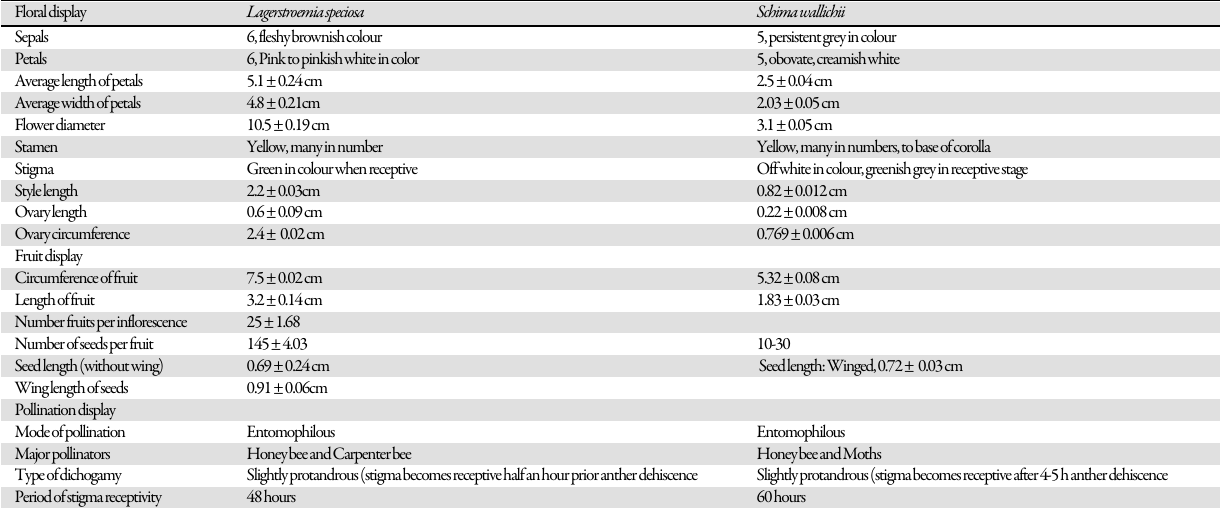
Table 1. Floral, pollination and seed display of L. speciosa and S. wallichii Floral